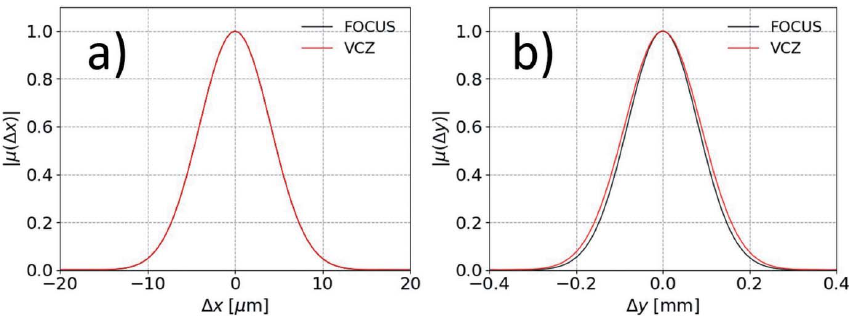
Figure 3 Horizontal ( a ) and vertical ( b ) profiles of the SDC for a typical third-generation synchrotron light source. Predictions based on the van Cittert and Zernike theorem (VCZ) are also reported for direct